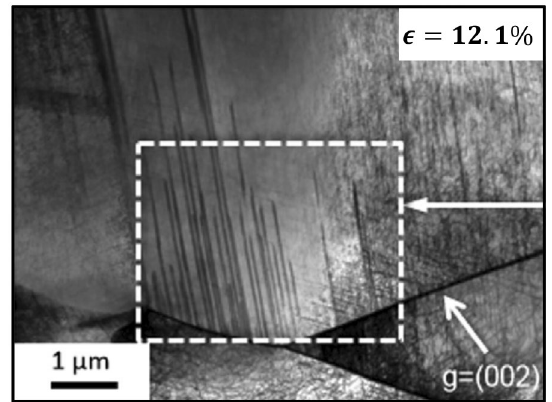
Figure 1. A bright-field TEM image depicting nanotwin nucleation from a GB in a CoCrFeMnNi HEA at a true tensile strain ǫ = 12.1% and temperature of 77 K. Taken from Ref. 42 with permission from